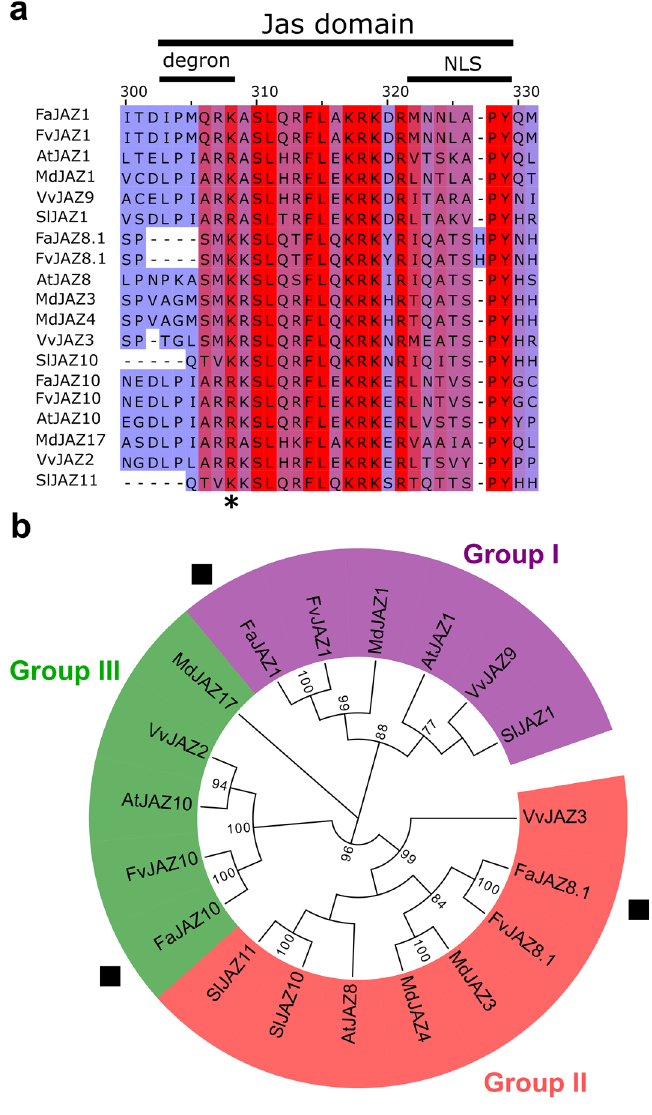
Figure 1. Comparison of Fragaria × ananassa JAZ1, JAZ8.1, and JAZ10 with their orthologs. Multiple alignment of Jas domain ( a ) and phylogenetic analysis for FaJAZ1, FaJAZ8.1, FaJAZ10 with their orthologs ( b ). Asterisk (*) in ( a ) denotes conserved residues for the interaction with COI1, InsP 5 , and JA-Ile according to previously reported 11 . Gaps are indicated by dashes. The red color indicates a 100% identity of amino acid residues and turns bluer with increasing amino acid diversity. Numbers in tree nodes show bootstrap values > 50%. The GenBank accession codes are available in the Material and Methods section. Fa, Fragaria × ananassa ; JAZ, JASMONATE-ZIM